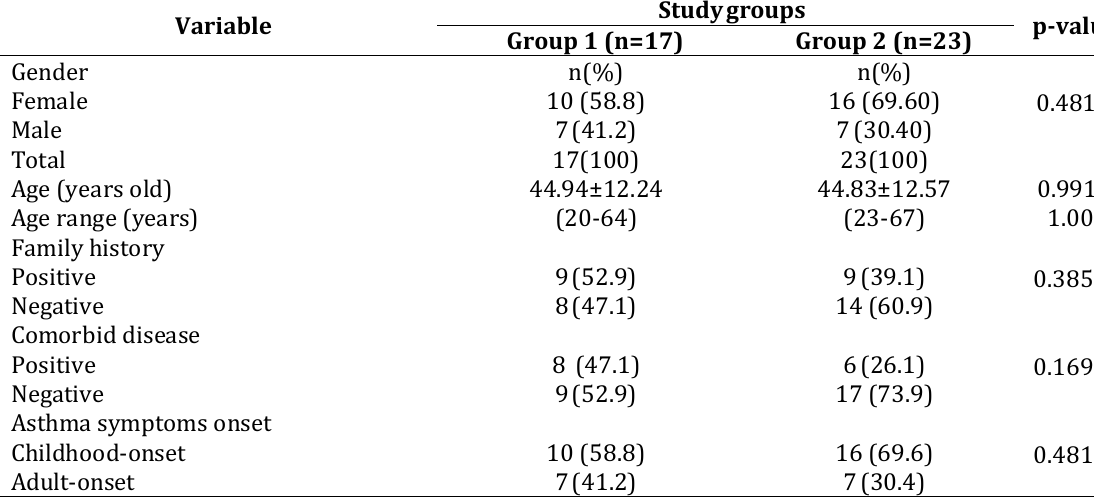
Table I. Demographic data and disease characteristics